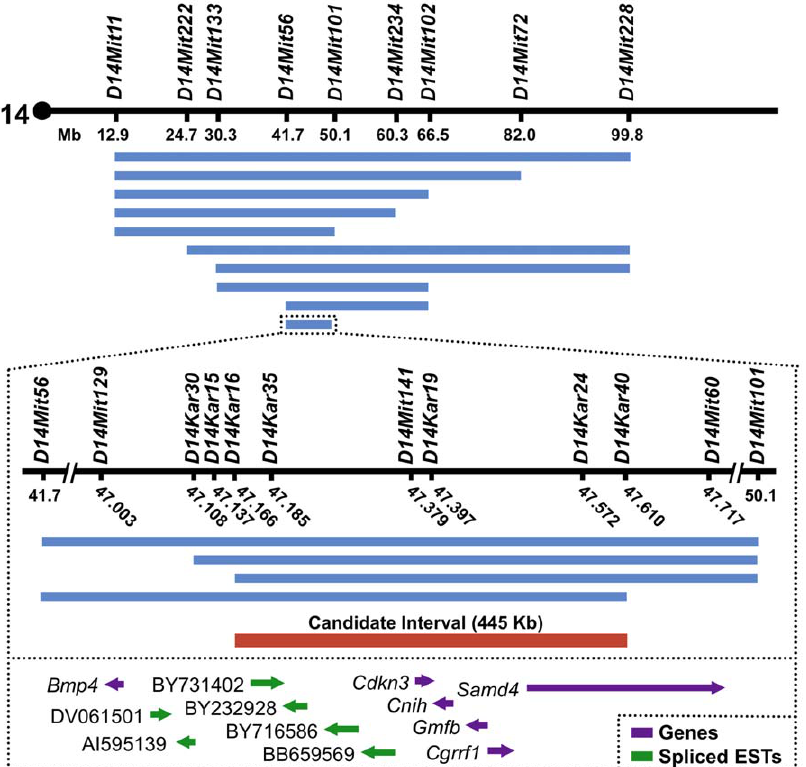
Figure 2. Positional cloning of the chromosome 14 Ecl gene. CSS-14 offspring were phenotyped as circling or non-circling and genotyped at SSLP markers across chromosome 14. Due to incomplete penetrance of the circling phenotype, only circlers were used to narrow the candidate interval. Blue bars depict regions of SWR homozygosity in CSS-14 circlers; each bar represents multiple circling mice with the same genotype. The Ecl candidate gene interval (red bar) was defined as the region of SWR homozygosity common to all CSS-14 circlers. This interval spans 445 Kb from D14Kar16 to D14Kar40 and includes five annotated genes and four spliced ESTs (bottom panel). The coding sequence of Bmp4 was excluded from the candidate interval by two independent crossovers.